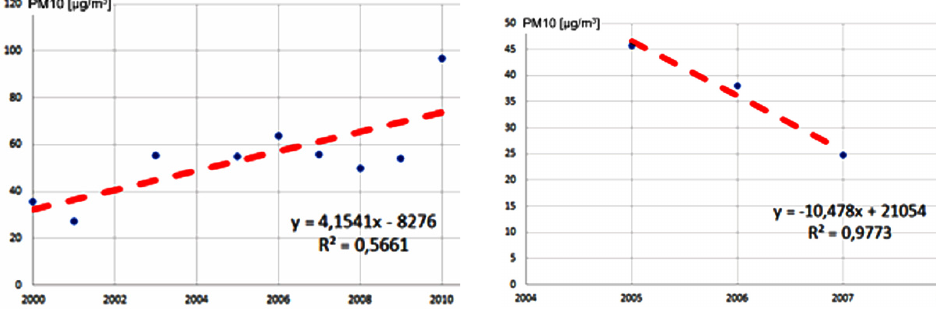
Fig. 6. Selected measuring points with opposite directions of the linear trend: (A) Ostrowiec Świętokrzyski (station: SkOstrowWios) – negative trend with high R2 coefficient, but based only on three measurements and therefore not very reliable (B) Kraków (station: MpKrakowWIOSPrad6115) – a growing trend. Symbols as in figure 5 (source: author’s original